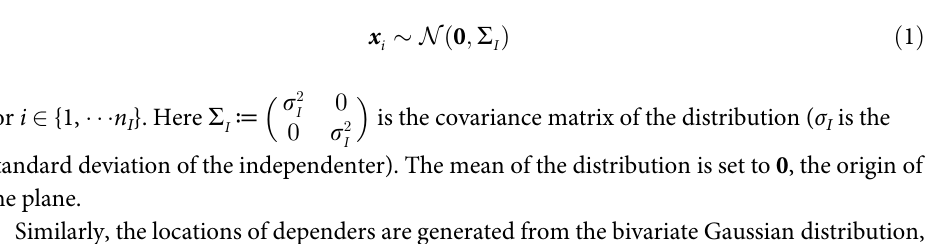
Fig 1. Schematic illustration of the simulation process. In this example, the parameters were set as follows: n I = 5, n D = 5, σ I = 10, σ = 1, n exp = 10. The simulation started from the spatial distributions of agents generated from one latent state of social group D organization, determined by parameters of the mixed Gaussian processes, n movement” data sets were then generated using the process described in the section on ordered alignment of agents. The vertical chains of the 30 circles represent single-file movement (the number of each circle is the agent id). Adjacency matrices G {1, 2, ... 10} were generated from orders in the single-file movement data set, and were convolved to a single adjacency matrix G , which was passed to the social network analysis. Finally, a social network graph was produced, with clustering of the local community (bottom graph). This flow is a single simulation process, which is run 1000